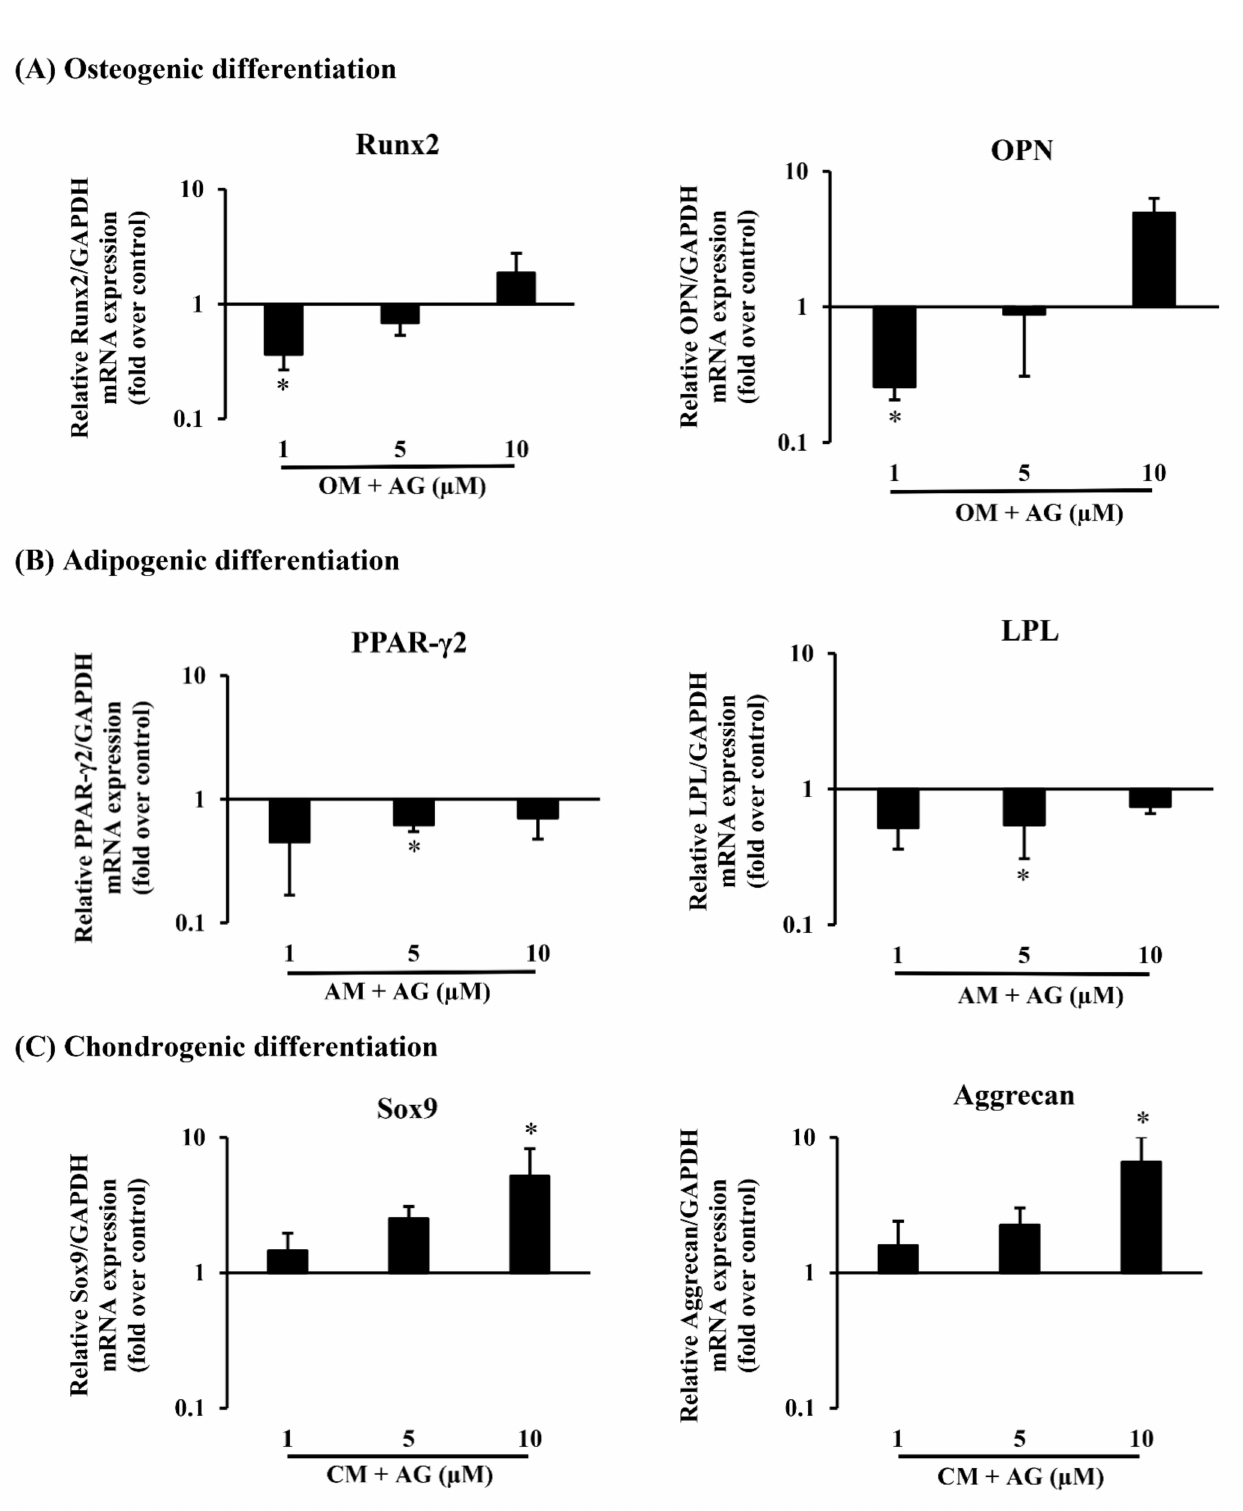
Figure 5. The effects of different doses of AG (1,5 and 10 µ M) on tri-lineage differentiation potentials of cells from SPFP tissues on day 21. ( A ) Osteogenic differentiation: (Runx2, OPN), ( B ) Adipogenic differentiation: (PPAR- γ 2, LPL), ( C ) Chondrogenic differentiation: (Sox9, Aggrecan). Gene expression of tri-lineage potentials was assessed using real-time PCR. The bar means SD. Data is shown as mean ± SD ( n = 10). Statistical significance was calculated using a one-way ANOVA test and significance is represented on graphs as * p -value <